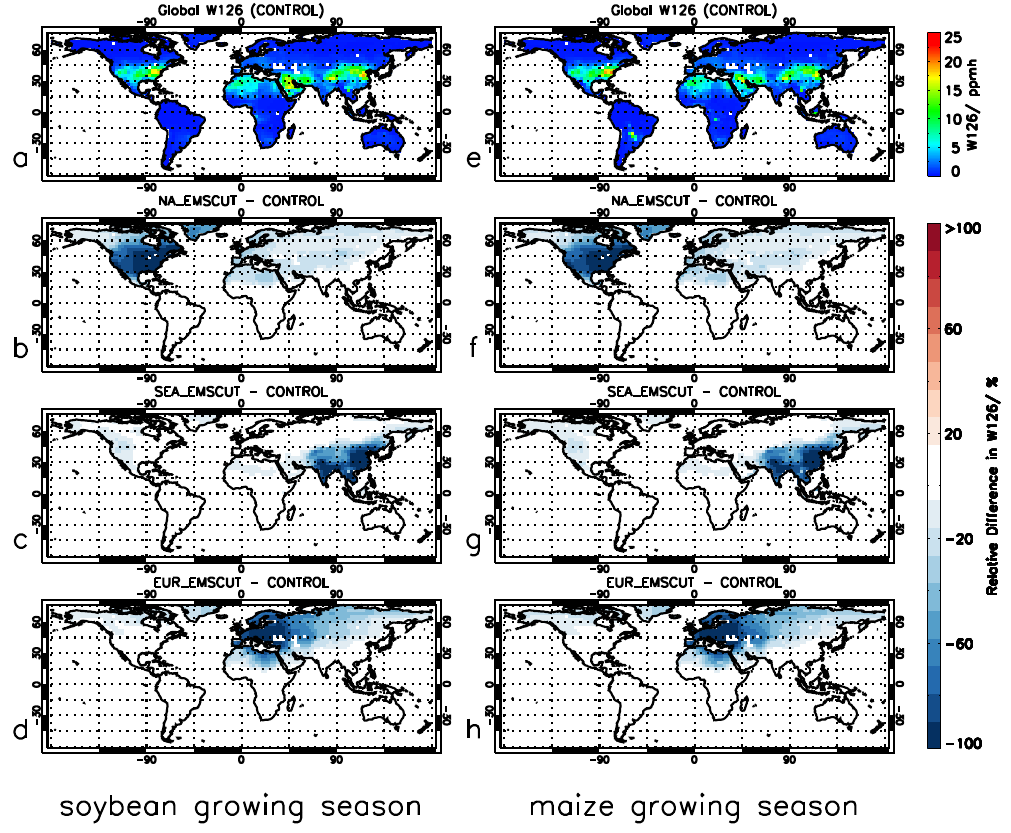
Fig. 9. As Figure 7 but for the W126 index, and the soybean (a-d) and maize (e-h) growing seasons.